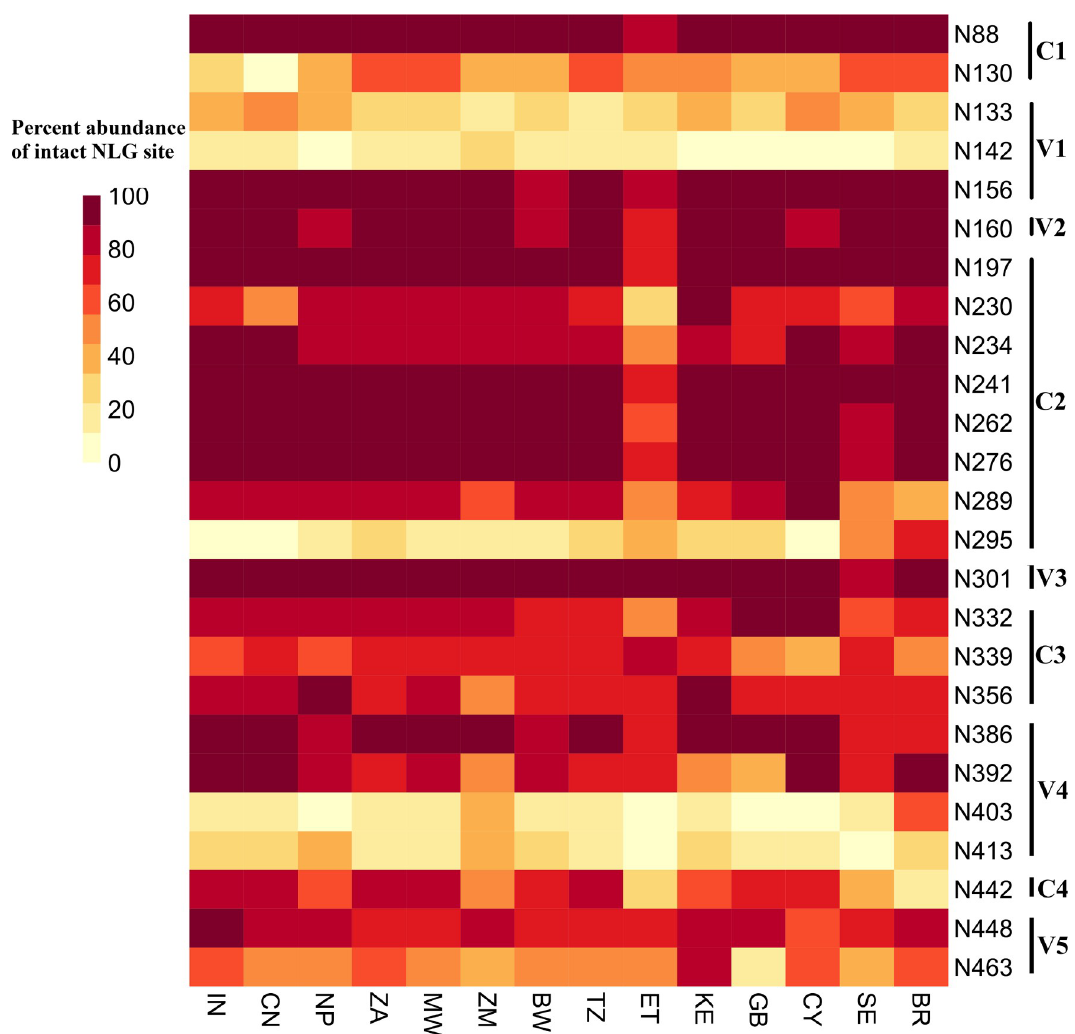
Fig 3. Assessment of potential N-linked glycosylation sites. A heatmap comparison of abundance of pNLG sites plotted on Y axis against countries plotted on X axis. Each pixel represents 1 pNLG site data from 1 country. Specific domains of pNLGs have been indicated along the Y axis. Color key represents correlation of color intensity with abundance of pNLGs ranging from 0 to 100.